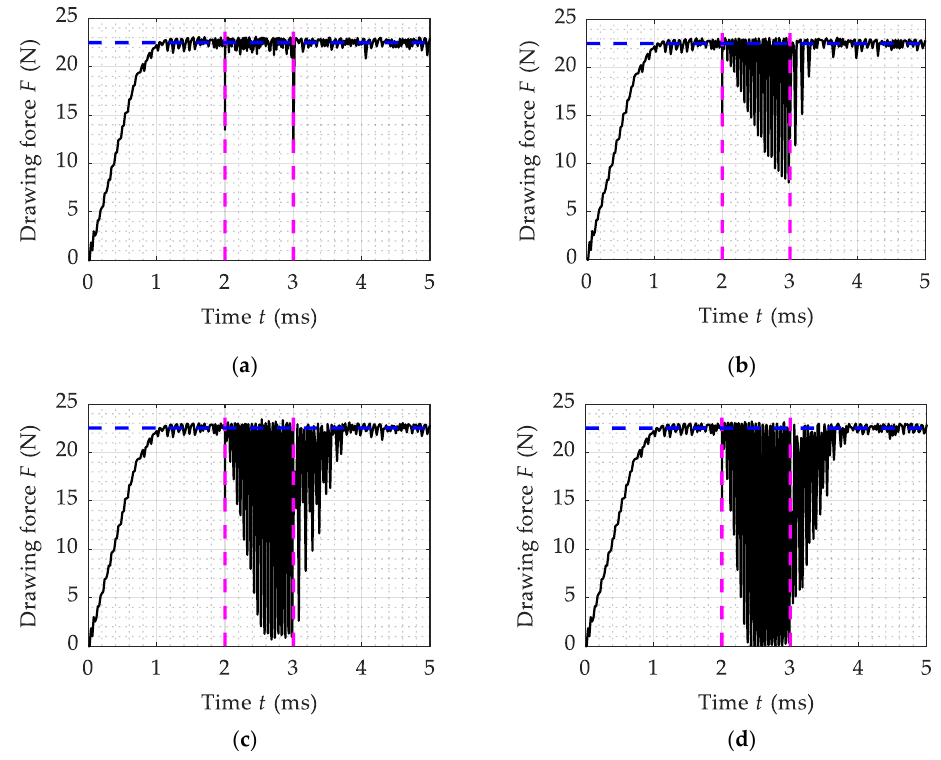
Figure 5. Influence of ultrasonic amplitude on time-variation of the drawing force: ( a ) A = 2 µ m; ( b ) A = 4 µ m; ( c ) A = 6 µ m; ( d ) A = 8 µ